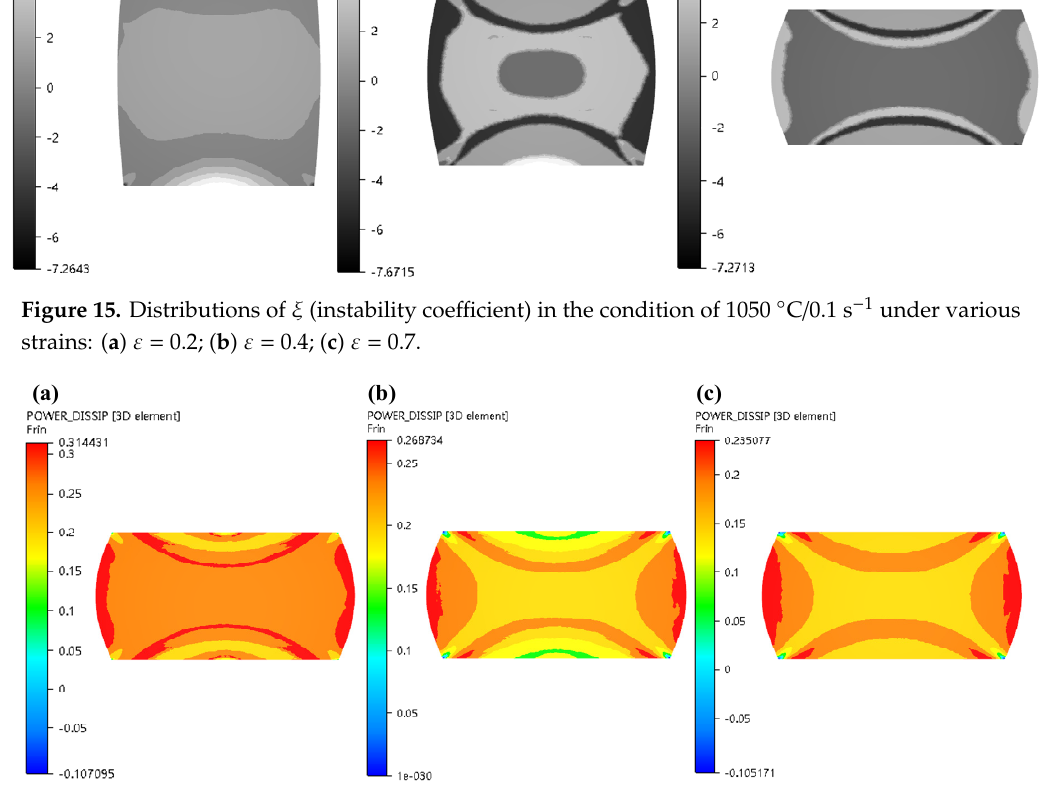
Figure 17. Distributions of ξ (instability coefficient) in the condition of 1050 °C/0.7 (T = 1050 °C, ε = 0.7) under various strain rates: ( a ) ε  = 0.1 s − 1 ; ( b ) ε  = 0.5 s − 1 ; ( c ) ε  = 1 s − 1 . (a) (b) Figure 18. Distributions of η (power dissipation coefficient) in the condition of 0.5 s − 1 /0.7 ( ε  = 0.5 s − 1 , ε = 0.7) under various temperatures: ( a ) T = 1000 °C; ( b ) T = 1100 °C.